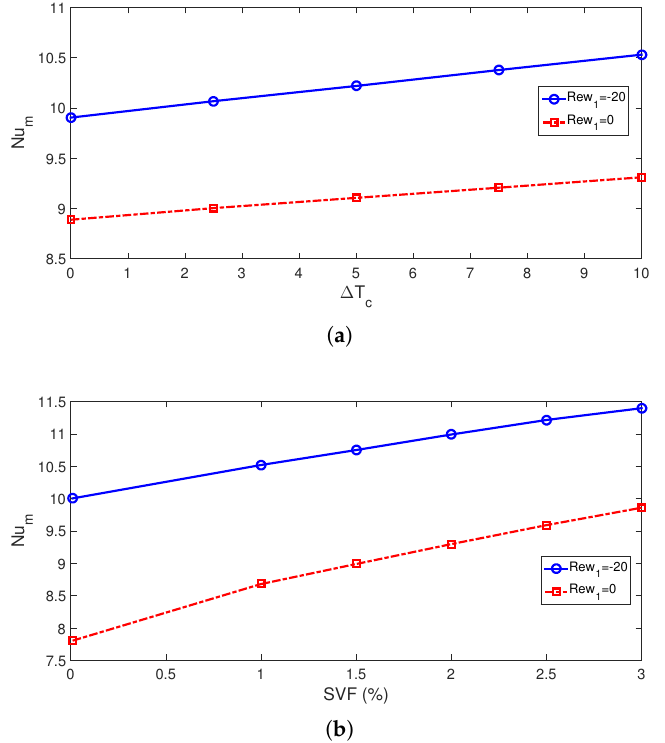
Figure 9. Impacts of subcooled temperature (( a ), SVF = 3%) and SVF of NPs ( ∆ T = 10, ( b )) on the variation of average Nu ( ( Rew 1 ,Rew 2 ) = ( − 20, − 20 ) , Rc = 0.1H, Sc = 6Rc).